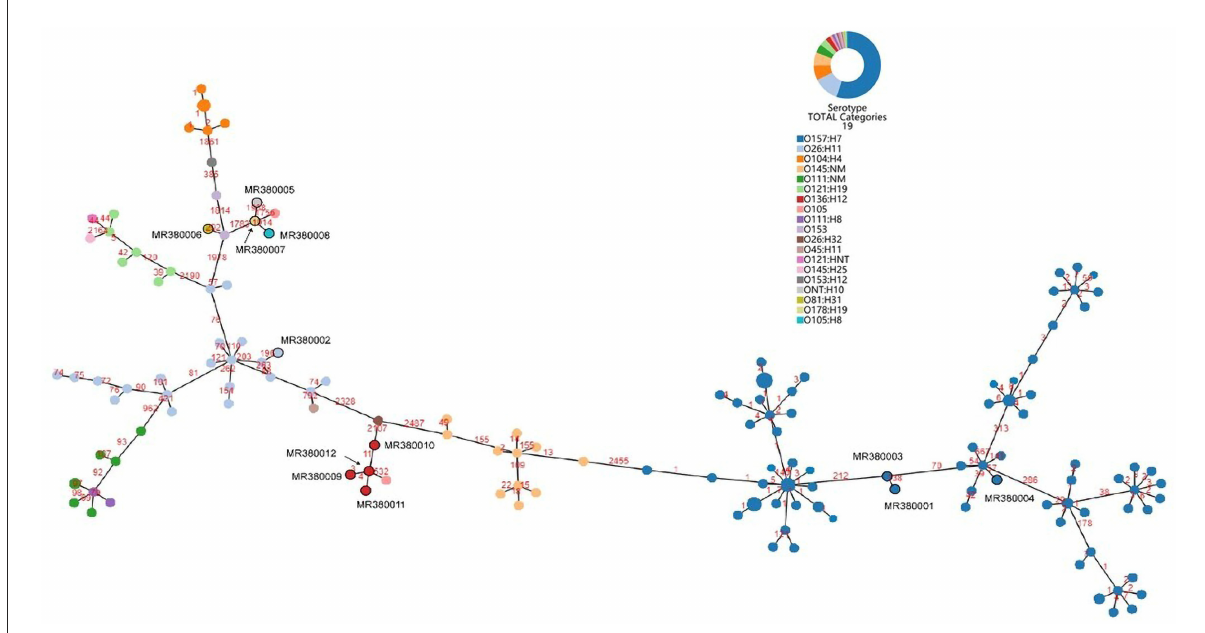
FIGURE2 Minimum spanning tree for 12 STEC isolates from 289 samples and 157 STEC strains from NCBI based on the 2,586 loci, a total of 19 serotypes, different colors represent different